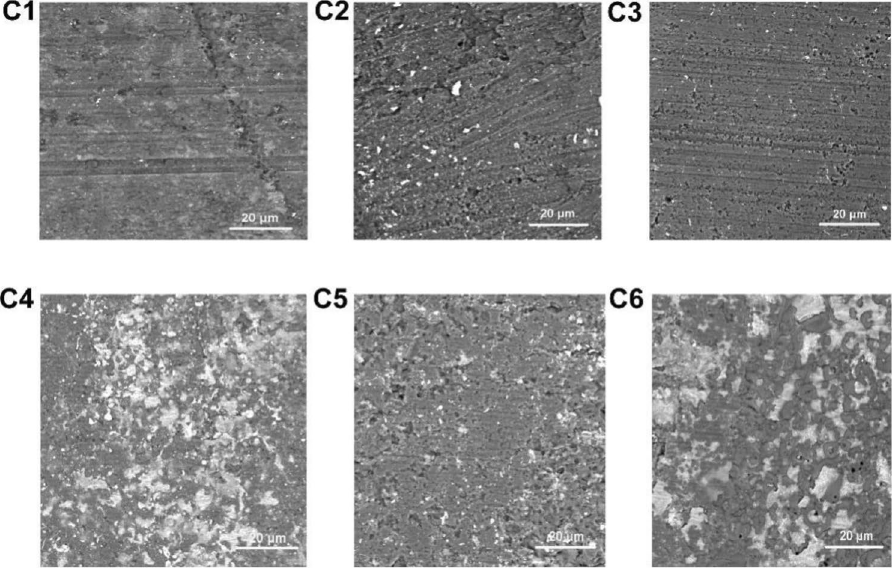
Figure 10. The worn surface morphology of MAO coatings ( C1 ): The concentration of NCNs is 0 g/L; ( C2 ): 0.4 g/L; ( C3 ): 0.8 g/L; ( C4 ): 1.2 g/L; ( C5 ): 1.6 g/L; ( C6 ): 2.0 g/L; Adobe Illustrator CS5, https:// www. adobe. com/ cn/ produ cts/ illus trator. html# scroll).